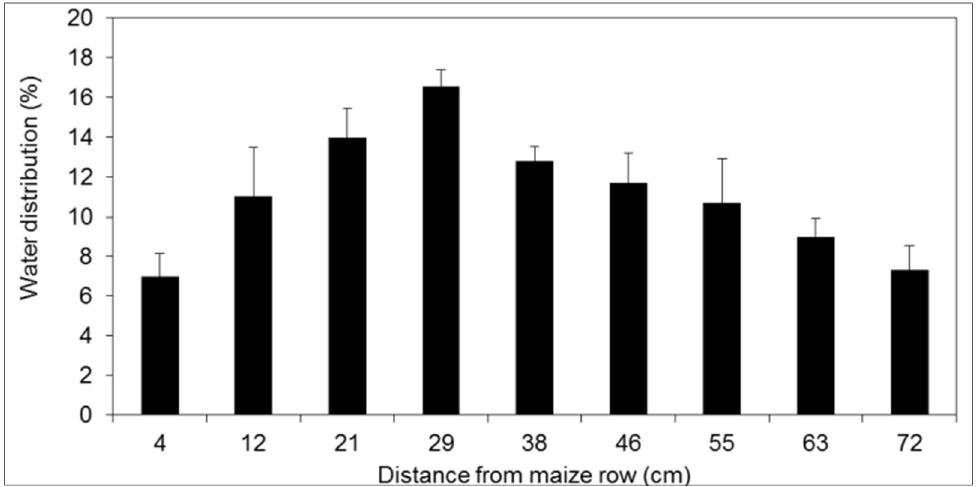
Figure 7. Spatial variability of the throughfall measurements collected with throughfall collectors. Mean values of the three trays are reported. Error bars indicate standard